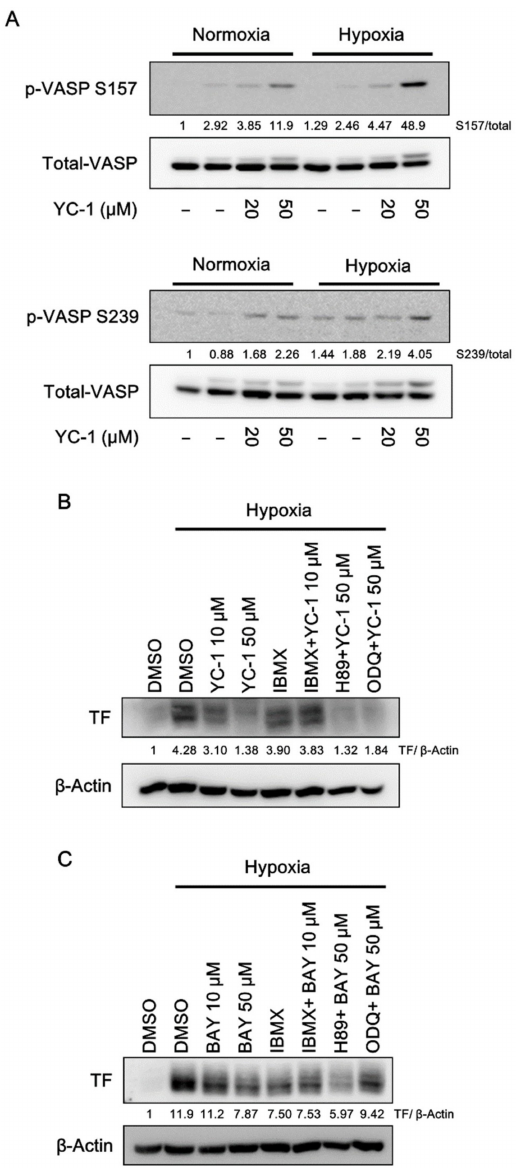
Figure 4. YC-1 activates cyclic nucleotide-dependent protein kinases in A549 cells. ( A ) A549 cells were pretreated with YC-1 for 1 h and incubated under normoxia or hypoxia for another 1 h. Cell lysates were subjected to Western blotting for phospho-VASP. ( B , C ) A549 cells were pretreated with the PDE then treated with YC-1 or BAY 41-2272 (BAY) for 1 h and incubated under hypoxia for another 24 h. TF expression was determined by Western